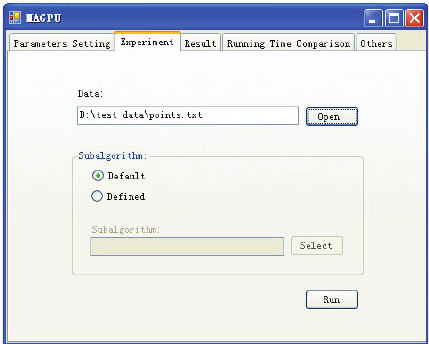
Figure 6: An interface of the software for GPU implementation of membrane algorithms with a nested